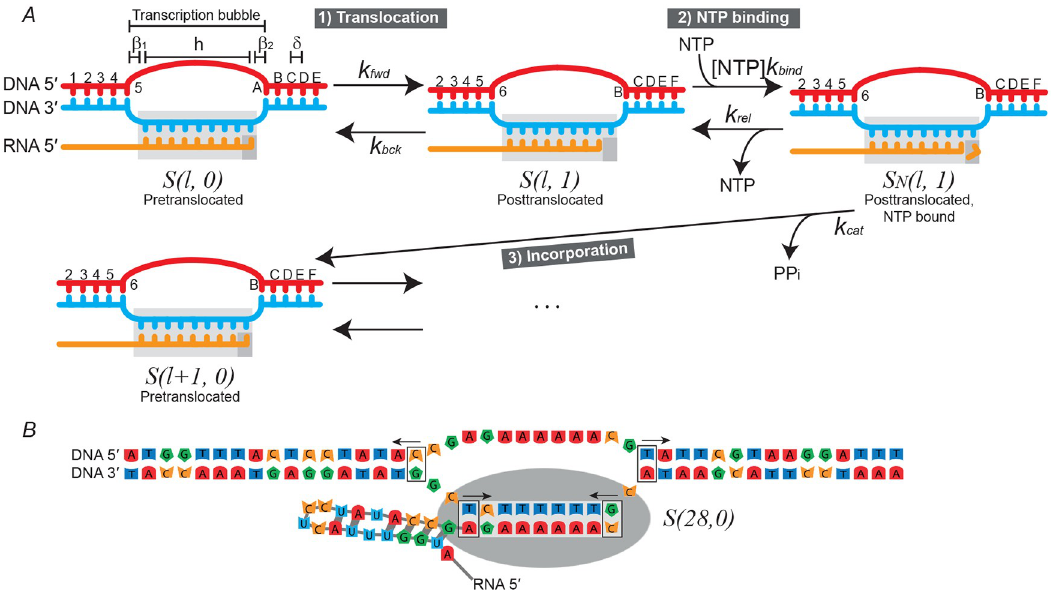
Fig 2. State diagrams of RNA polymerase. (A) The model of the main transcription elongation pathway, which shows the postulated states; the pathways for interconversion; and the rate constants that govern each part of the reaction. The transcription bubble is the set of β 1 + h + β 2 bases (see main text for definitions) in the double-stranded DNA which are unpaired. States are denoted by S ( l , t ) where l is the length of the mRNA and t is the position of the polymerase active site (small grey rectangle) with respect to the 3 0 end of the mRNA. Polymerase translocation displaces the polymerase by a distance of δ = 1 bp = 3.4 Å . During polymerisation the chain is extended by one nucleotide. (B) Instantiated posttranslocated state of RNA polymerase transcribing the rpoB gene sequence, with β 1 = 2, h = 9, β 2 = 1. Forward translocation requires melting two T/A basepairs (right arrows). Backward translocation requires melting two C/G basepairs (left arrows). The mRNA secondary structure would also require reconfiguration [16,